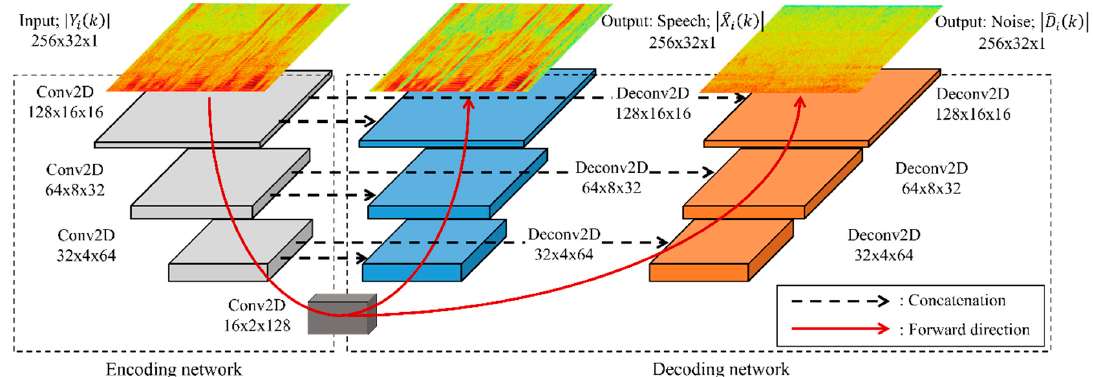
Figure 2. Network architecture of the proposed multi-task learning U-Net (MTU-Net)-based single-channel speech enhancement.